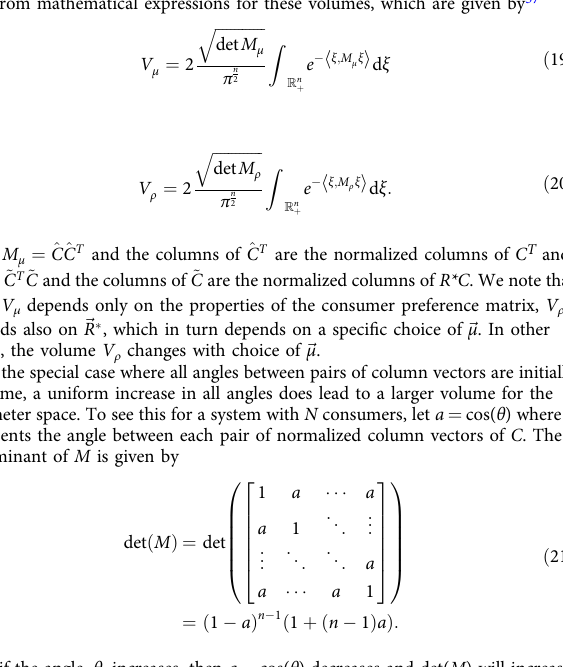
ffiffiffiffiffiffi p (cid:8) (cid:9) C D 1